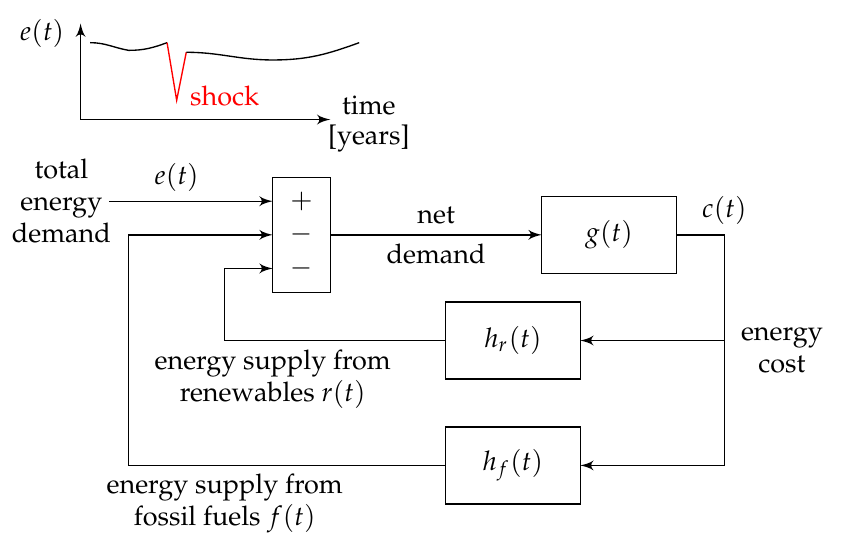
Figure 4. An illustrative feedback system describing the effects of “economic shocks”: periods of low consumption are modeled as negative impulse signals, which cause reactions and counter-reactions that evolve in a closed feedback